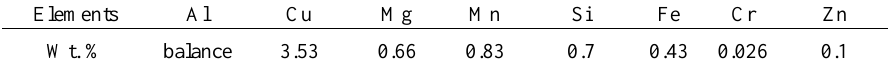
Table 1. Chemical composition of 2017A-T4 aluminum alloy (wt.